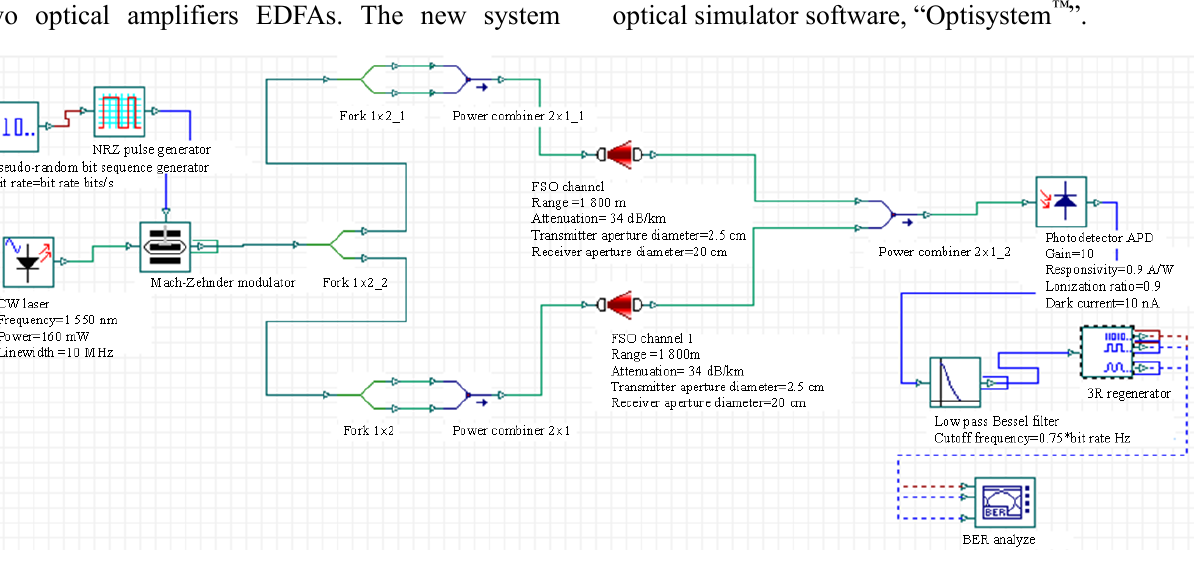
Fig. 2 Two-channel FSO system.